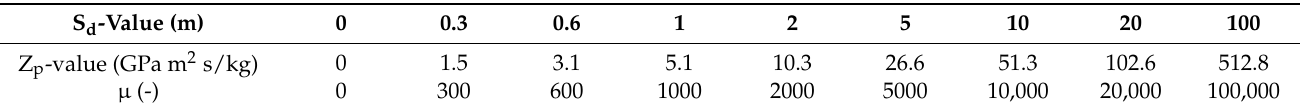
Figure 2. Moisture storage function of mineral wool and cellulose insulation from WUFI database. Table 2. Properties of investigated air–vapour barriers and without a vapour barrier. S d -values of 0–0.6 were only used in internal humidity classes 1–3, and S d -values of 5 and 20 were used for internal humidity classes 4 and 5. The water vapour permeability of air was set to 0.195 · 10 − 9 kg/Pa m